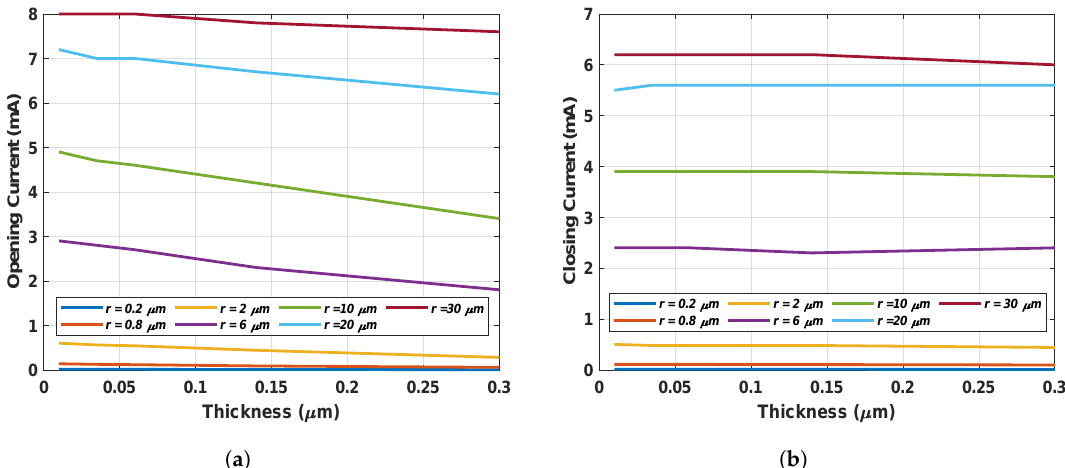
Figure 12. The dependence of the ( a ) opening and ( b ) closing currents on the thickness of the VO 2 resistor.